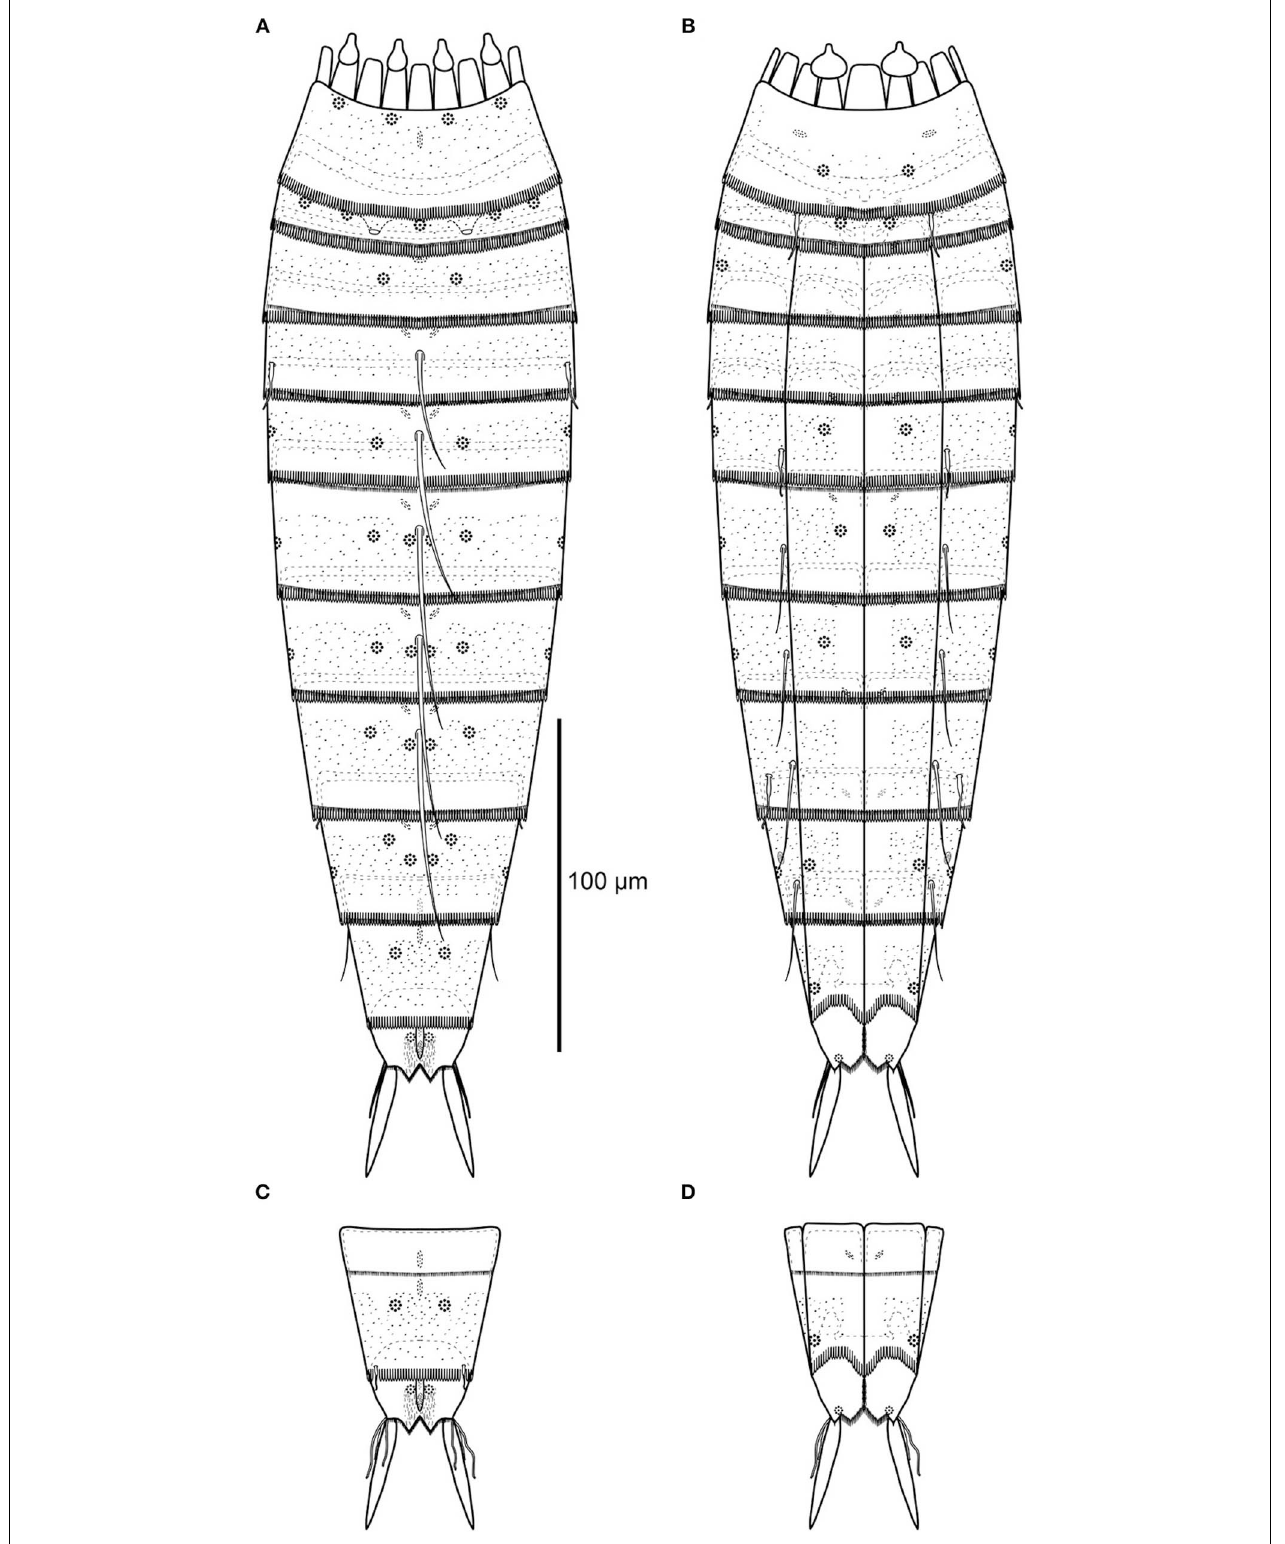
FIGURE 2 | Line art illustrations of Echinoderes augustae sp. nov. (A) Female, dorsal view. (B) Female, ventral view. (C) Male, segments 10 to 11, dorsal view. (D) Male, segments 10 to 11, ventral view.